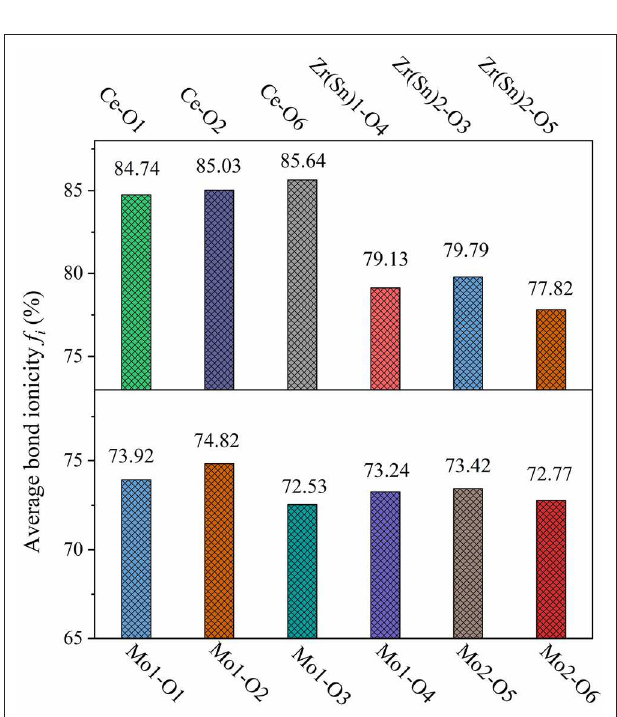
FIGURE 8 | Bond ionicity for Ce 2 (Zr 0.94 Sn 0.06 ) 3 (MoO 4 ) 9 ceramics sintered at 800 ◦